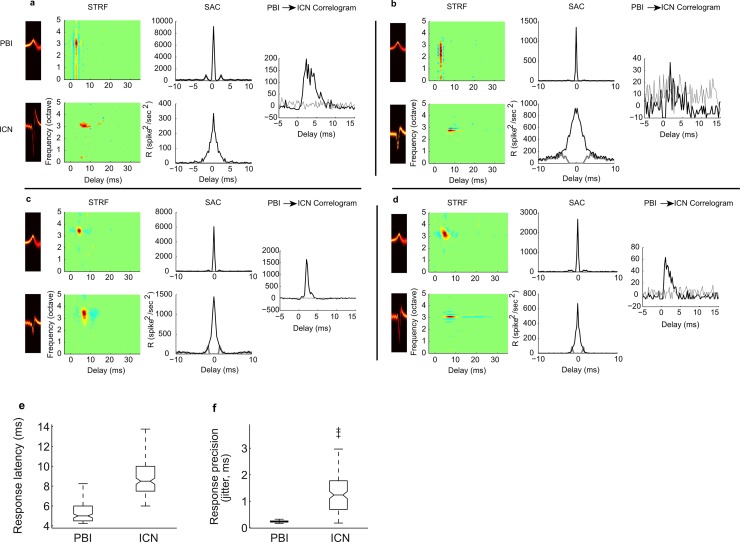
Spiking and spectrotemporal integration characteristics of PBI-ICN pairs recorded from the same tetrode.In each example, we show the STRFs (left panels, top row for PBI and bottom row for ICN), the spike train SACs (middle panels), and the crosscorrelogram between PBI and ICN (right panel). Only statistically significant samples of the STRF (p < 0.001) are shown, and samples that do not exceed the significance threshold are set to zero (same convention for all figures; red indicates excitatory response above the baseline firing rate, blue indicates suppressive and/or inhibitory response, and green is the baseline activity). The units of frequency are in octave relative to 1 kHz. As seen in these 4 examples, PBIs often have broader bandwidths than ICNs (panels a, b, d). PBIs also exhibit shorter response latency and faster integration times (panels a–d). Finally, spike-timing precision is higher for PBIs as seen in the SAC (panels a–d, gray line corresponds to the unshuffled autocorrelogram with central peak removed). Significant correlated activity was observed in the PBI-ICN crosscorrelogram between 0 to 5 ms delay in 89% of PBI-ICN pairs (t test, p < 0.001, gray line corresponds to the interspike interval shuffled crosscorrelogram). Overall, PBIs have shorter response latencies (panel e; range 4.2–8.2 ms; median 4.9 ms) and higher temporal precision (panel f; spike-timing jitter: range 0.17–0.32 ms; 0.23 ms median) compared to that of ICNs (latency range 6–13.8 ms; 8.5 ms median; jitter range 0.2–3.7 ms; 1.2 ms median, respectively). Underlying data can be found in S2 Data and S2 Code. ICN, inferior colliculus neuron; PBI, putative brainstem input; SAC, shuffled autocorrelogram; STRF, spectrotemporal receptive field.